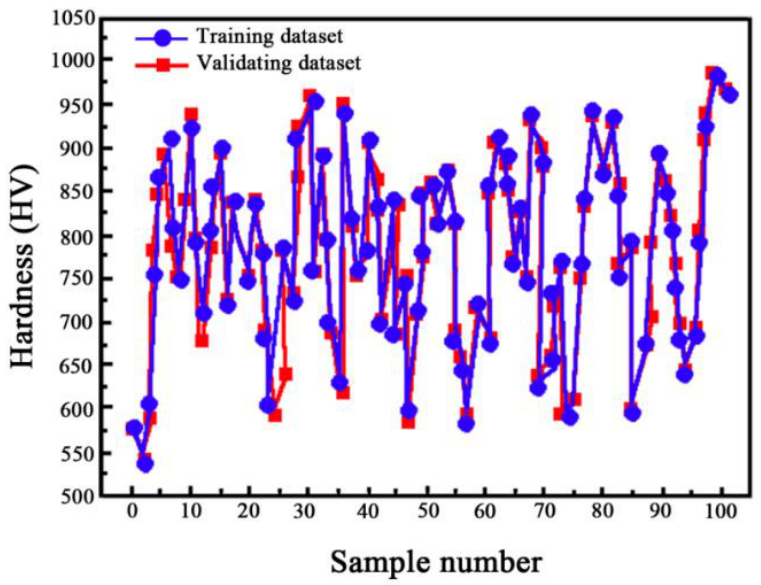
Figure 8. Microhardness values of Ni-TiN nanoplatings predicted by the BP model.